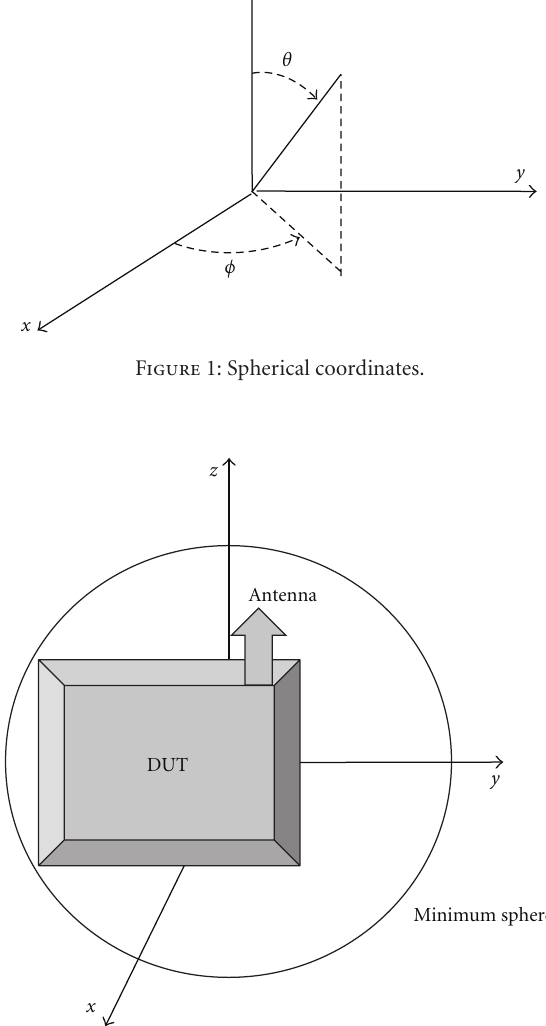
Figure 2: The DUT with mounted antenna contained in the mini- mum sphere of radius R min